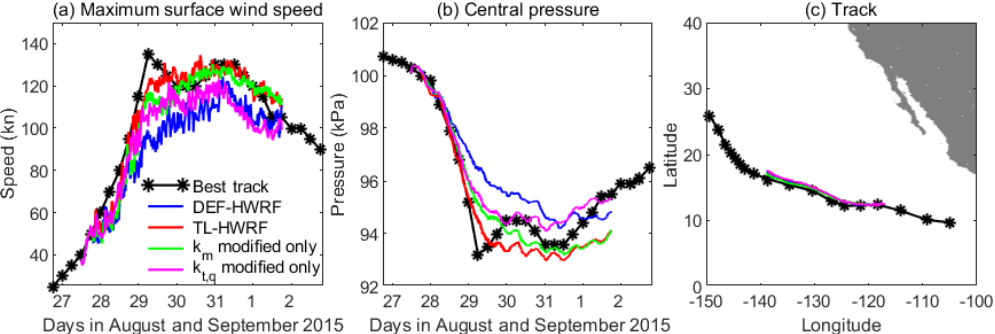
Figure 7. Comparison of HWRF-simulated maximum surface wind speed, storm central pressure, and track of Jimena (2015) with the best- track data (black). Blue curve indicates the simulation by the default HWRF (DEF-HWRF). Red curve indicates the simulation by the HWRF with inclusion of an in-cloud turbulent-mixing parameterization (TL-HWRF). Green curve represents the simulation in which only the eddy exchange coefficient for momentum is modified while keeping the eddy exchange coefficient for heat and moisture the same as the default. Magenta curve is opposite to the green curve in that only the eddy exchange coefficient for heat and moisture is modified.